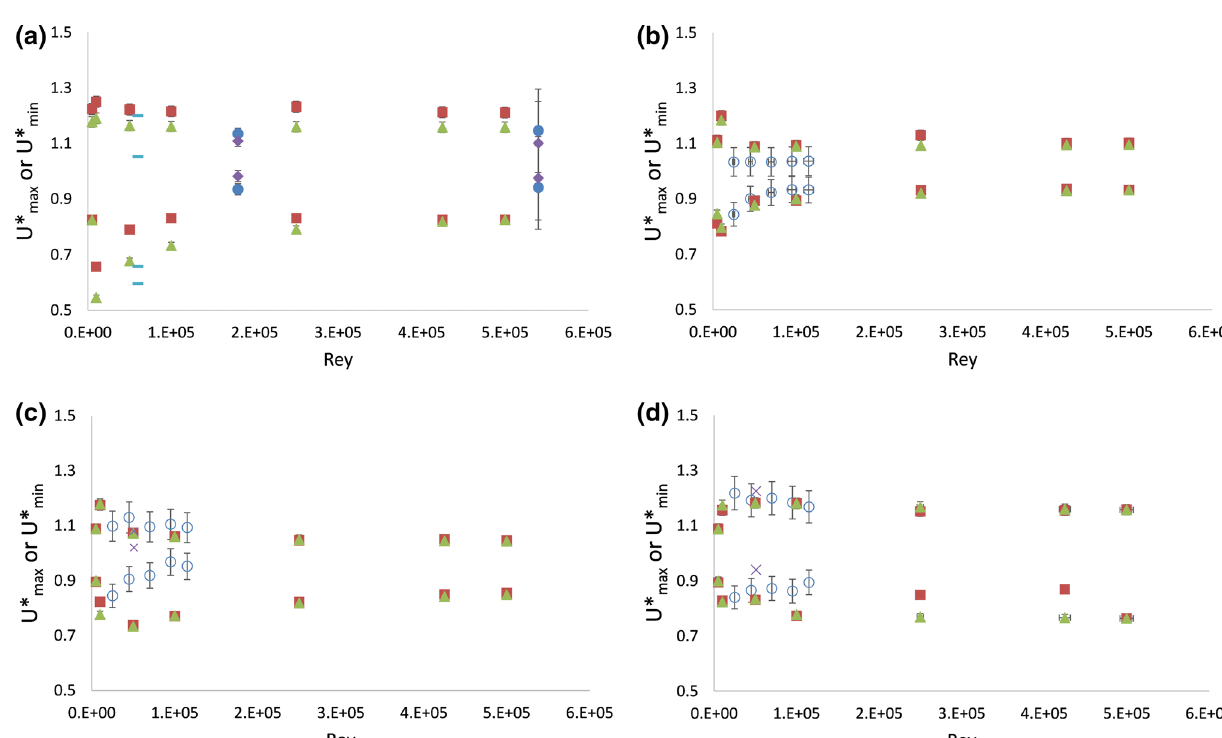
Fig. 5 Maximum and minimum time-averaged velocities along the pipe after a 90-degree elbow. The velocities should be within 10% of the cross-sectional area average velocity. a x/D = 0; b x/D = 5; c x/D = 10; d x/D = 50. ○ Rc/D = 1.0 (Hellström et al., 2013); ●